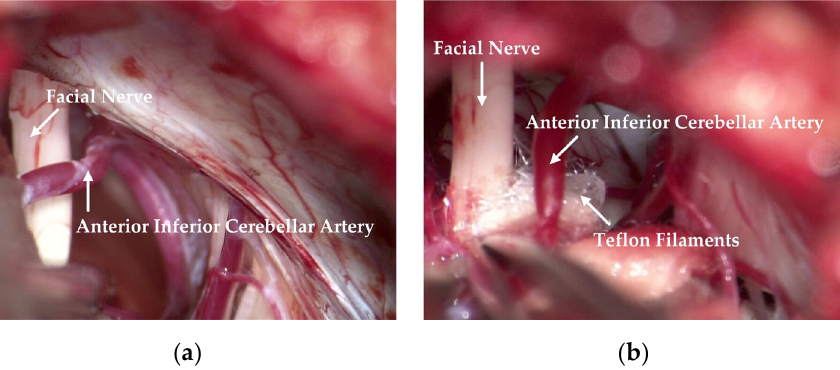
Figure 1. Relationship observed between the facial nerve and the responsible vessel during an operation. ( a ) The anterior inferior cerebellar artery crosses the facial nerve, resulting in compression. ( b ) Teflon filaments are inserted between the facial nerve and the anterior inferior cerebellar artery to relieve compression.